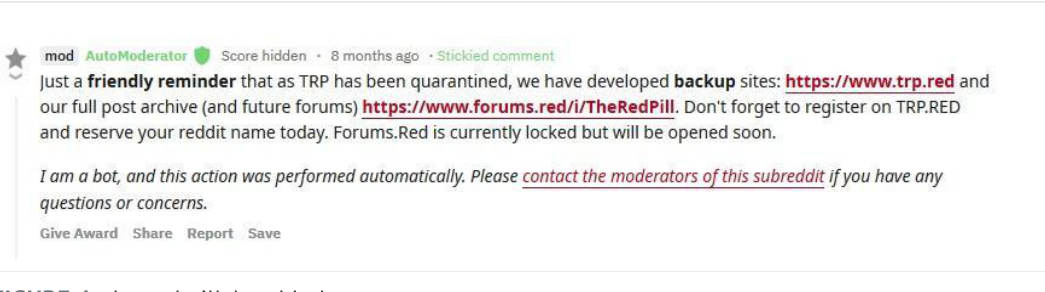
FIGURE 4: the red pill AutoModerator